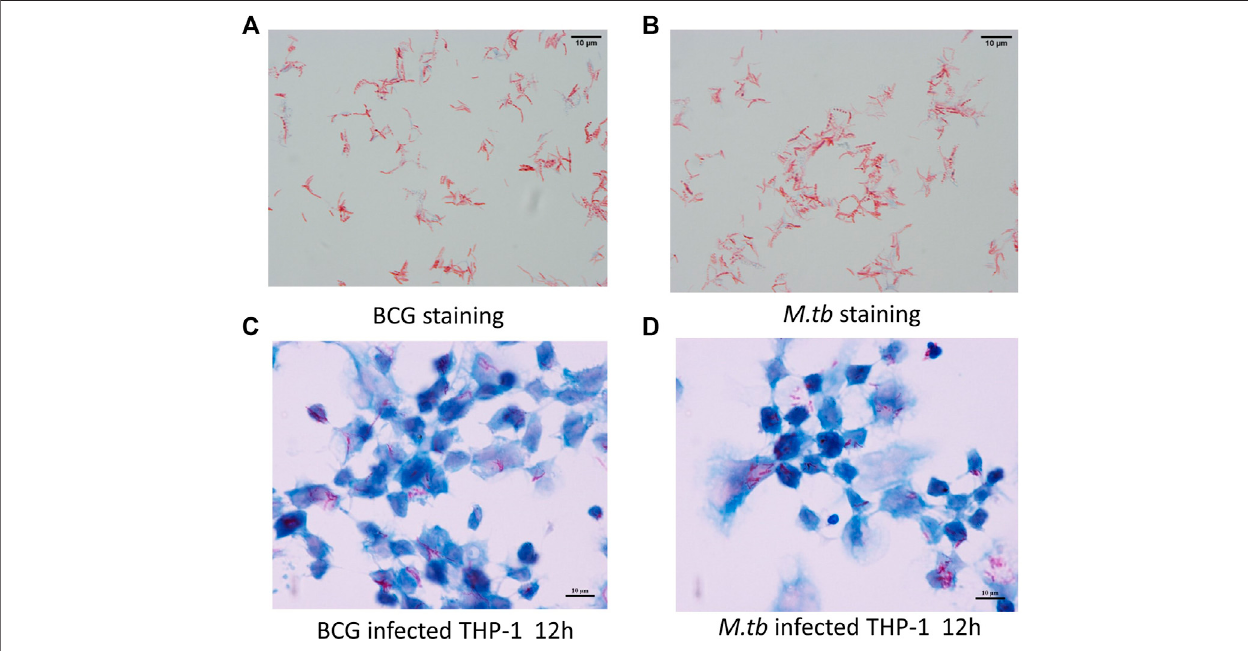
FIGURE 1 | Infection model. PMA-differentiated THP-1 cells were infected with M.tb and BCG for 12 h. Ziehl – Neelsen staining of the BCG in vitro cultured (A) and M.tb (B) . Ziehl – Neelsen staining to detect the survival of BCG (C) and M.tb (D) in THP-1 cells.